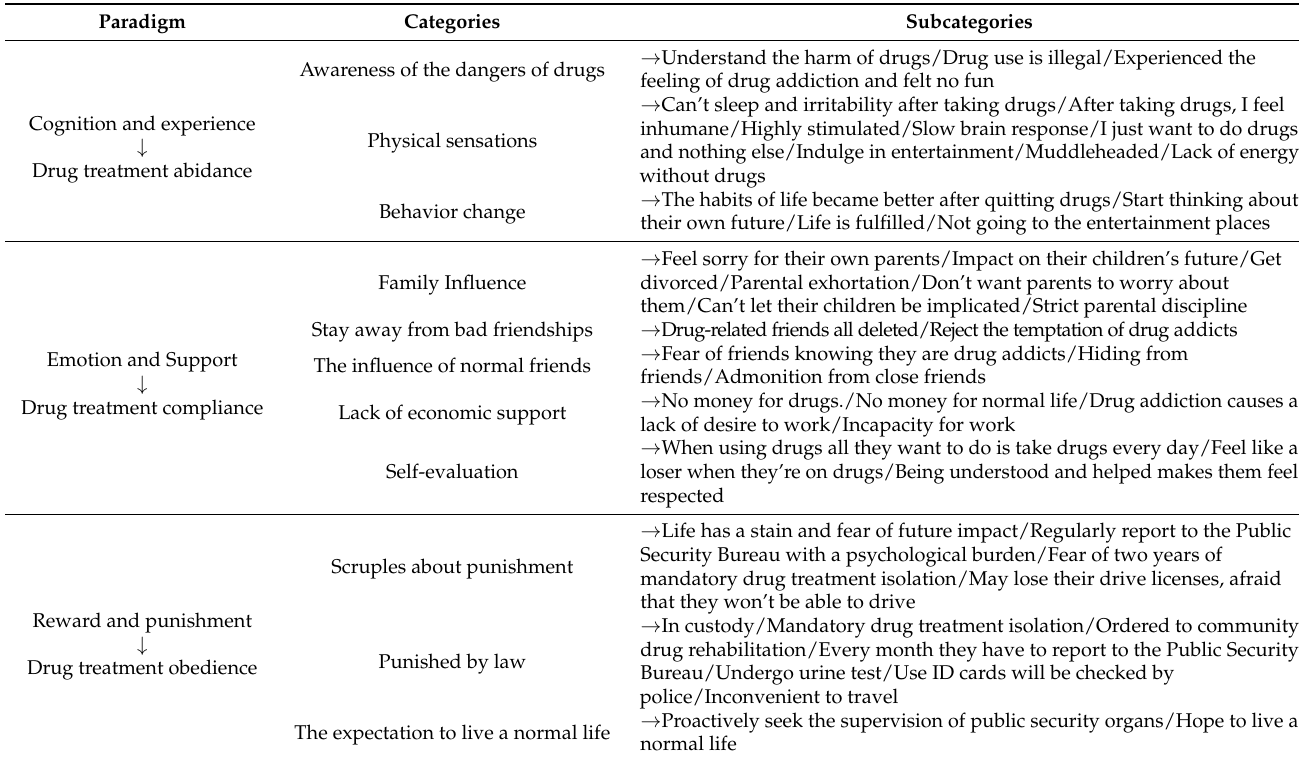
Table 2. Coding structure of narratives of